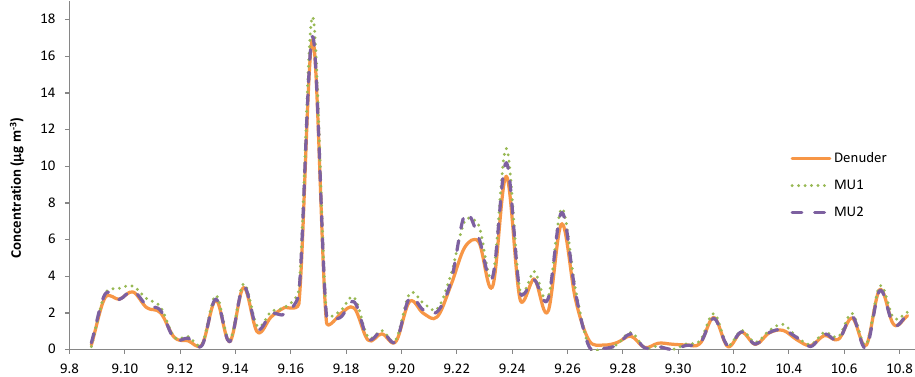
Fig. 4. Denuder and MUs measured SO 2 concentrations during the ETV period. 2 Figure 4. Denuder and MU measured SO 2 concentrations during the ETV period.